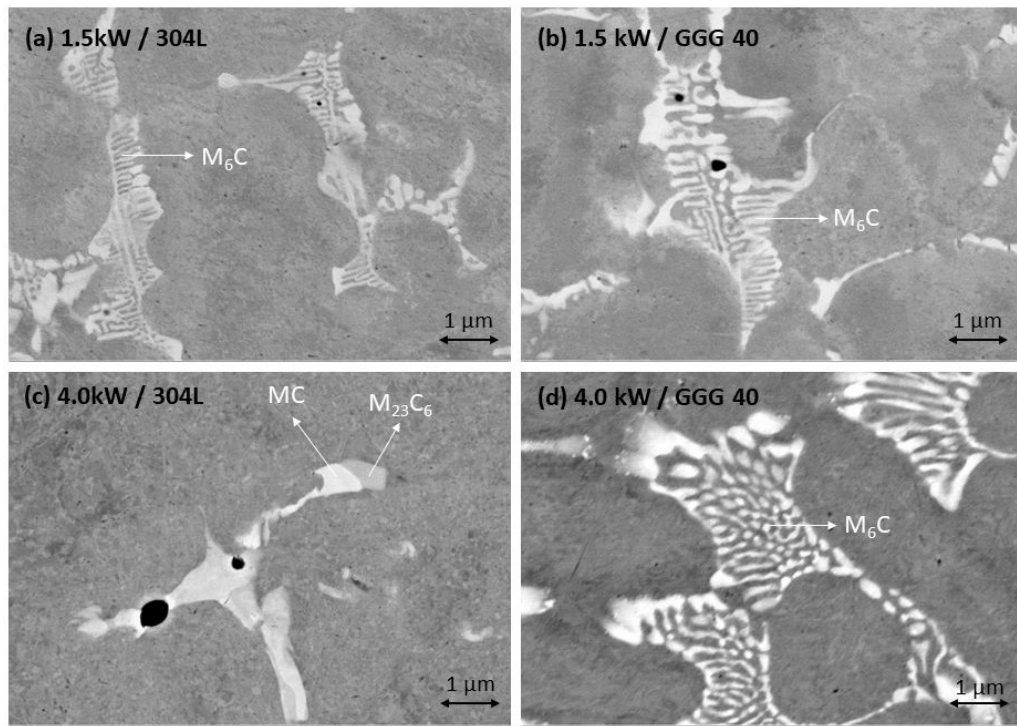
Figure 10. The detailed evaluation of the coating´s